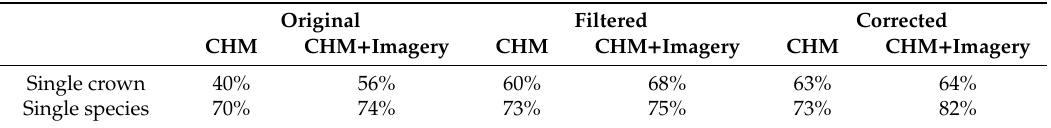
Table 3. Individual tree crown assessment comparing segmented objects produced with original, filtered or corrected canopy height model (CHM) in combination with imagery.